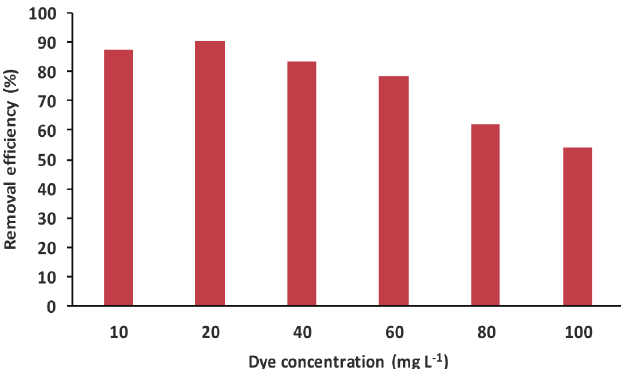
Fig. 7 – Effect of RR 198 concentration on photo-degrada- tion reaction (pH = 3, catalyst dosage = 2 g L –1 , irradiation: visible light)